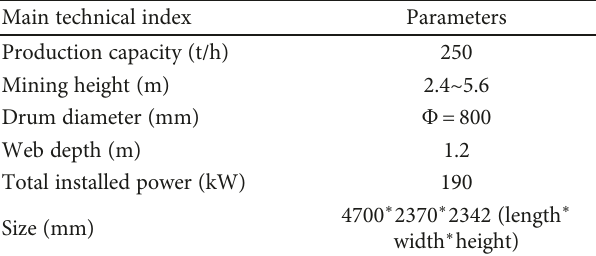
Table 1: Main technical parameters of the new